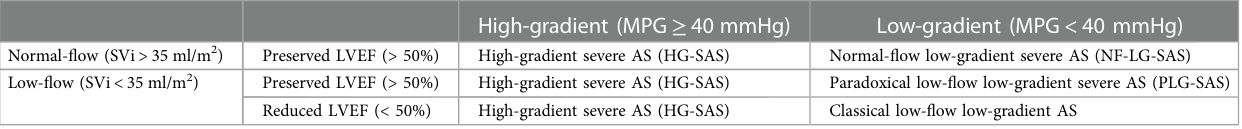
TABLE 1 Classi fi cation of AS with reduced AV area opening ( ≤ 1 cm 2 ) based on parameters measured in vivo using ultrasound imaging, according to (2,